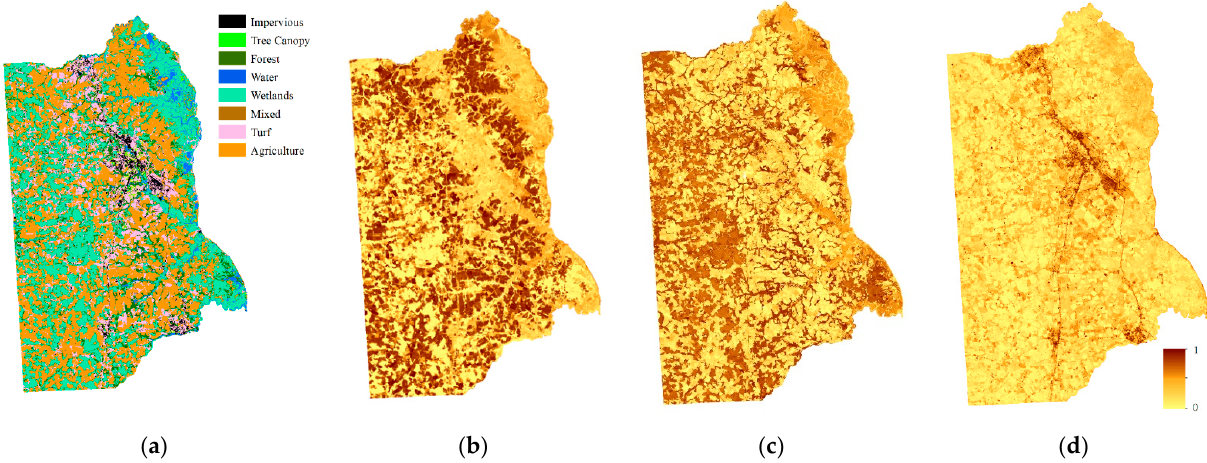
Figure 14. Fuzzy classification results and selected land cover type membership in Kent County: ( a ) classification result by SVM; ( b ) membership in agriculture; ( c ) membership in forest; ( d ) membership in impervious.